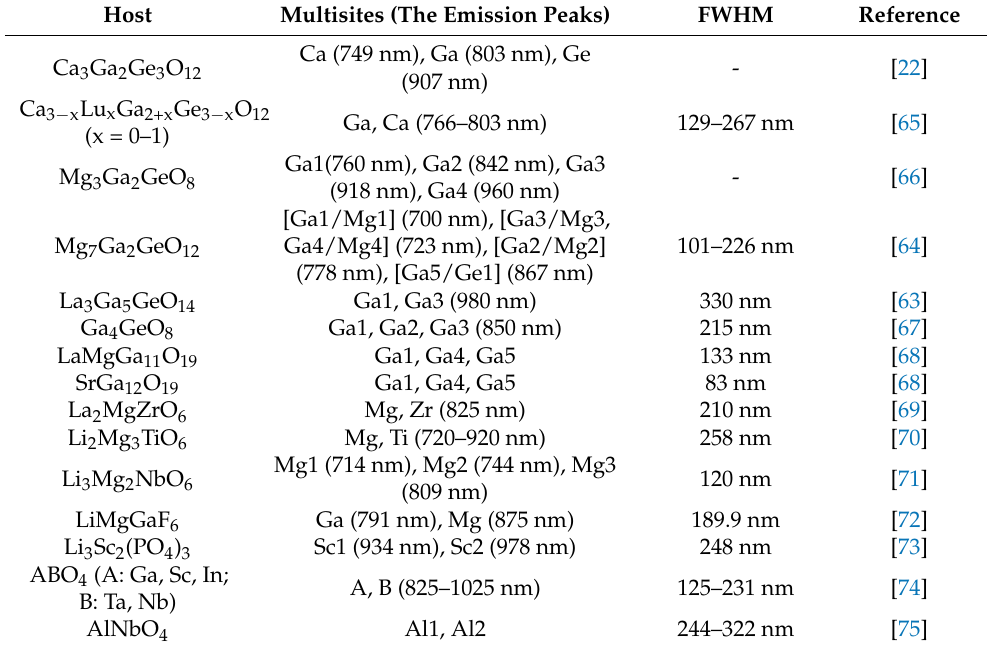
Figure 6. ( a ) Unit cell structure of LGGO and coordination environment of cations. ( b ) PL and PLE spectra of LGGO:Pr 3+ , LGGO:Cr 3+ and LGGO:Pr 3+ , Cr 3+ . Reprinted with permission from ref. [63]. Copyright 2019 American Ceramic Society. ( c ) Crystal structure of Mg 7 Ga 2 GeO 12 and coordination environment of Mg, Ga and Ge. ( d ) Gaussian fitting for the PL spectrum of Mg 7 Ga 2 GeO 12 :0.02Cr 3+ into four peaks. Reprinted with permission from ref. [64]. Copyright 2021 Elsevier Ltd. and Techna Group S.r.l. Table 3. Summary of structural and luminescent information for some Cr 3+ -doped multi-site phosphors. Host Multisites (The Emission